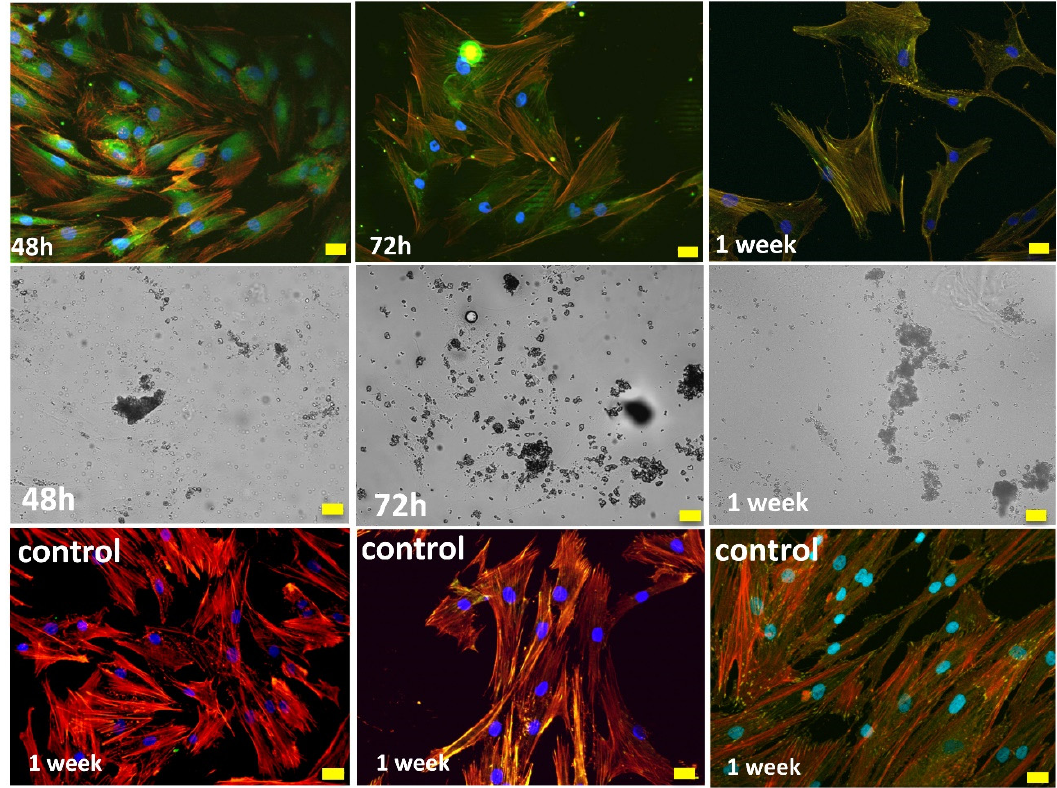
Figure 11. HOB ® Osteoblasts growing in the presence of the SG40TCP60 biomaterial. Images acquired in the confocal microscope in the fluorescence (upper row) and Nomarski mode (mid row). In red: actin cytoskeleton immunolabeled with rhodamine phalloidin, in green: vinculin immunolabeling for focal adhesions and in blue: DAPI-labeled nuclei. Representative images of control groups growing on glass are shown in the lower row. Scale bar equals 20 μ m.